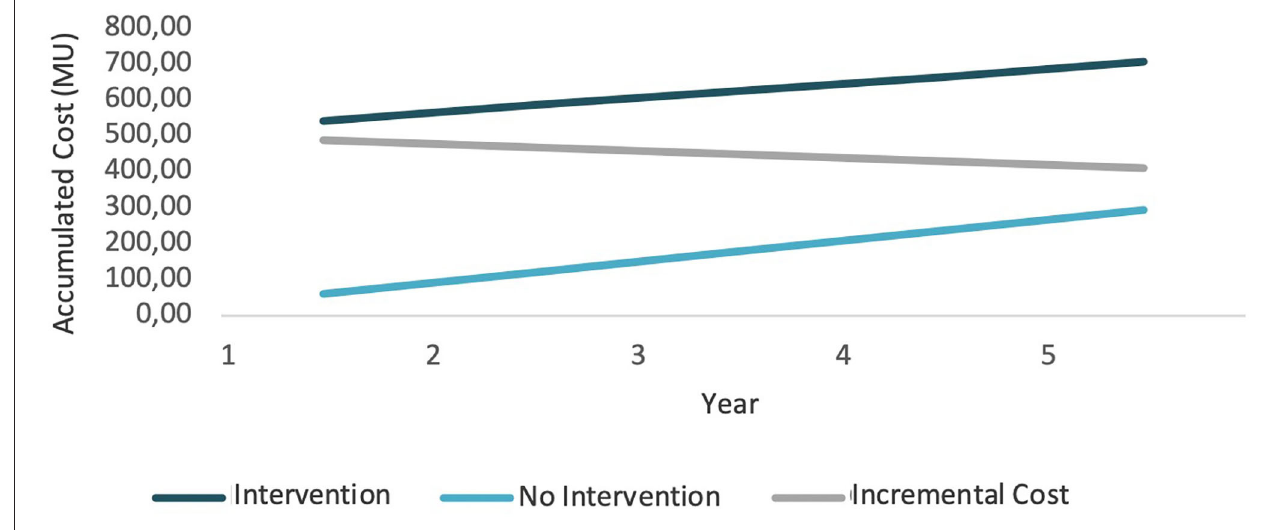
FIGURE 4 | Cost evolution (1).